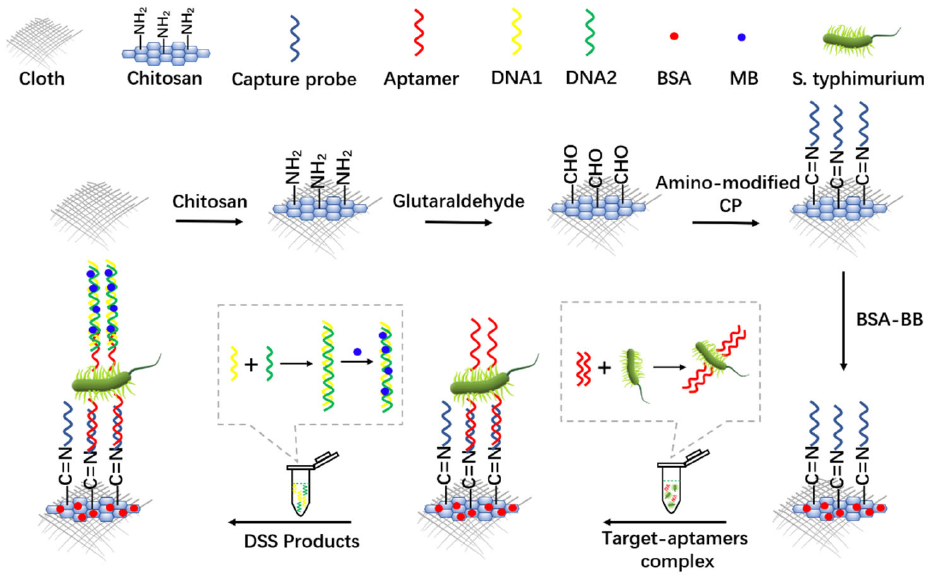
Figure 3. CSEA schematic for direct detection of Salmonella typhimurium (Adapted with permission from Ref. [14]. 2021, Li et al.).